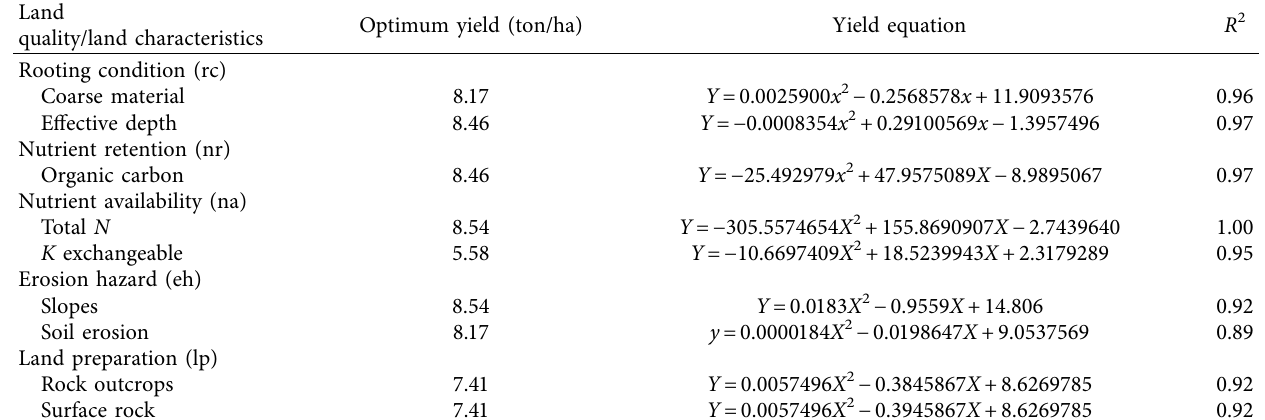
Table 7: Te optimum hybrid maize yield by the land quality and land